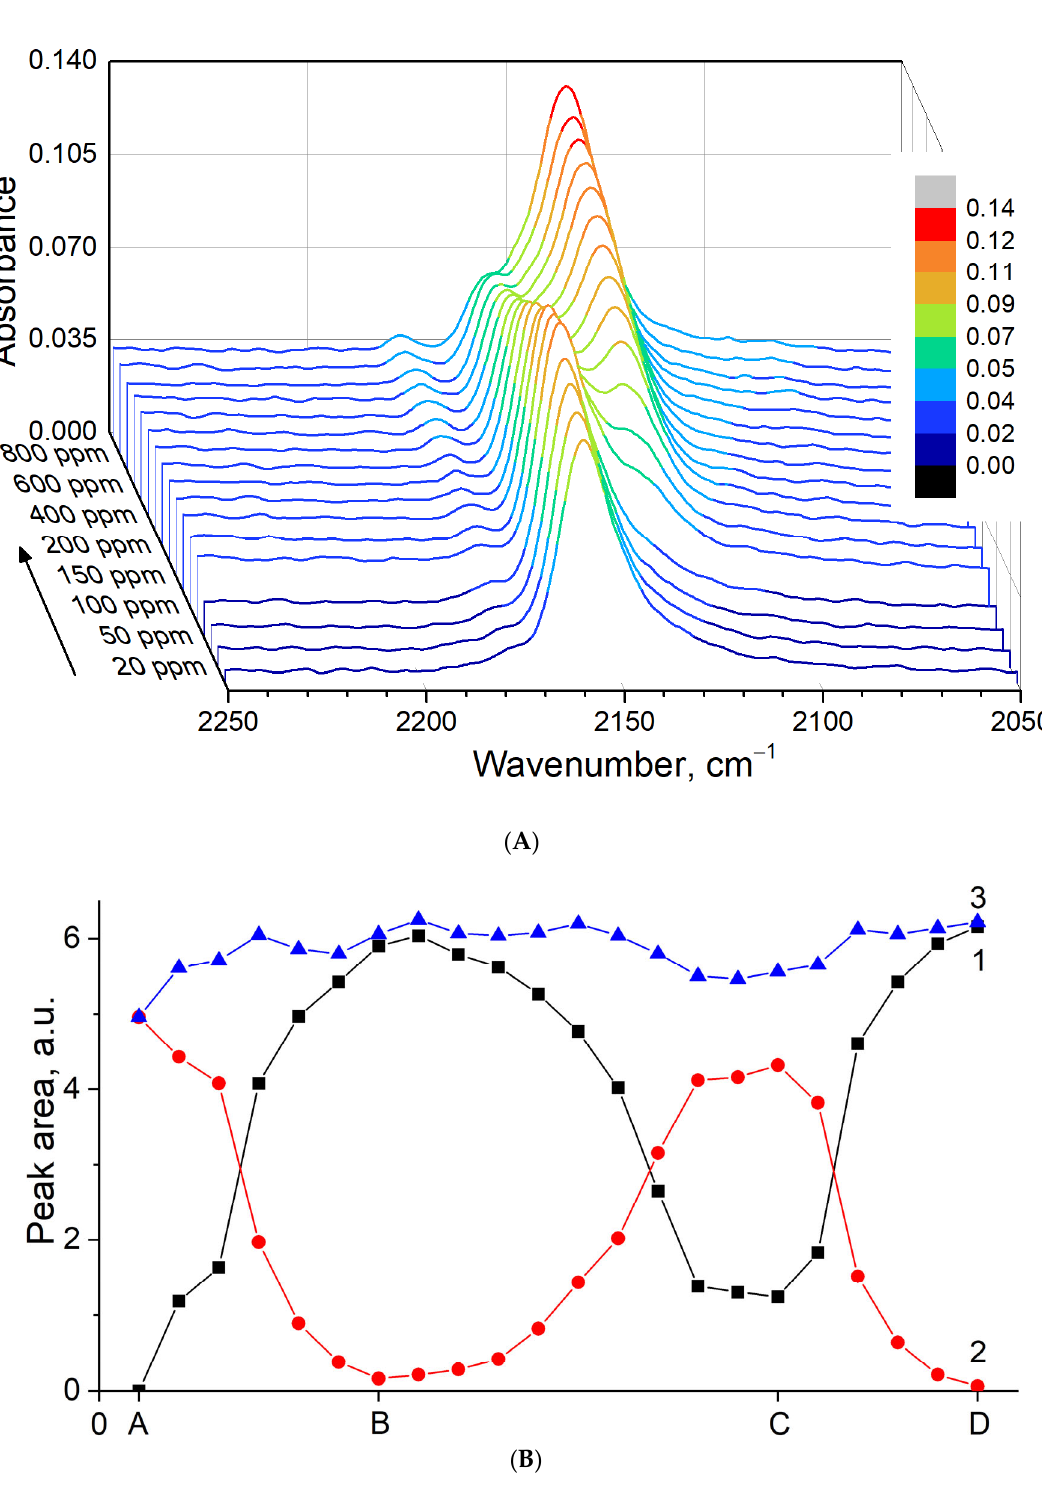
Figure 7. ( A ). Waterfall graph of difference FTIR spectra of CO adsorbed on Cu(NO 3 ) 2 ‐ MOR: 50 ppm of CO adsorbed (step A) followed by stepwise H 2 O adsorption (step B), evacuation (step C) and H 2 O re ‐ adsorption (step D). ( B ) Peak evolution of CO adsorbed on MOR ‐ Cu(NO 3 ) 2 during water adsorption ‐ desorption experiment; 2135 cm − 1 peak (1), 2157 cm − 1 peak (2) and total peak area (3);